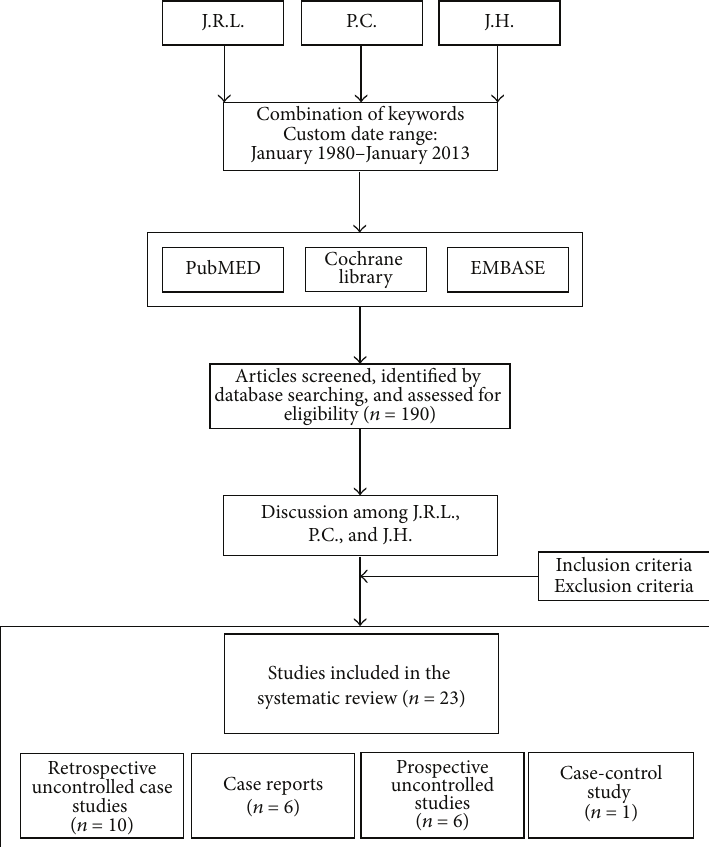
Figure 1: Flow chart shows the process of article selection for this